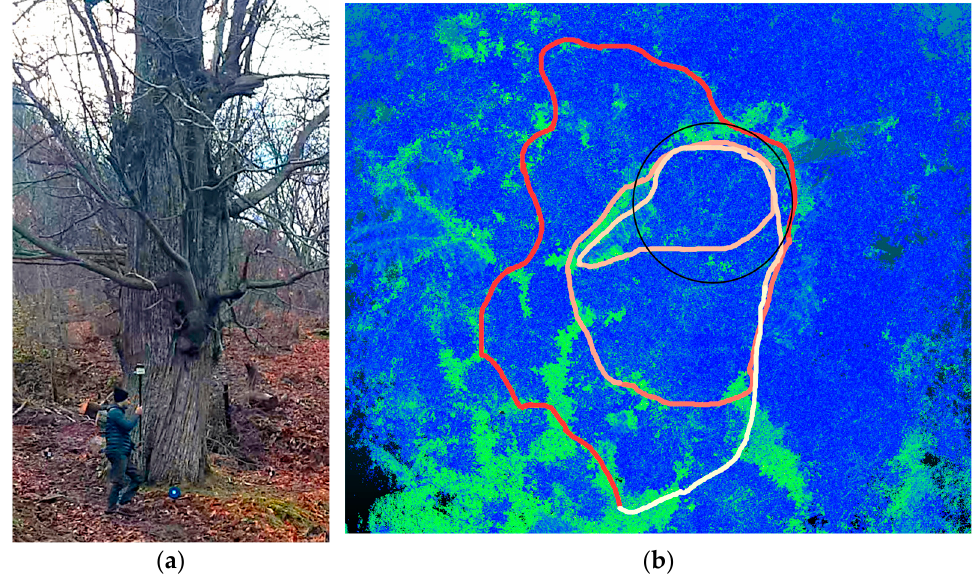
Figure 3. ( a ) The MLS detection of a tree (MT1) surrounding and target in winter. ( b ) Top view of the Kaarta Stencil-2 point cloud around one tree (black line) with the loop-closed trajectory. The line color change is based on the trajectory time, with red at the beginning and white at the end. The blue and green colors represent the points’ intensity obtained during the MLS point cloud